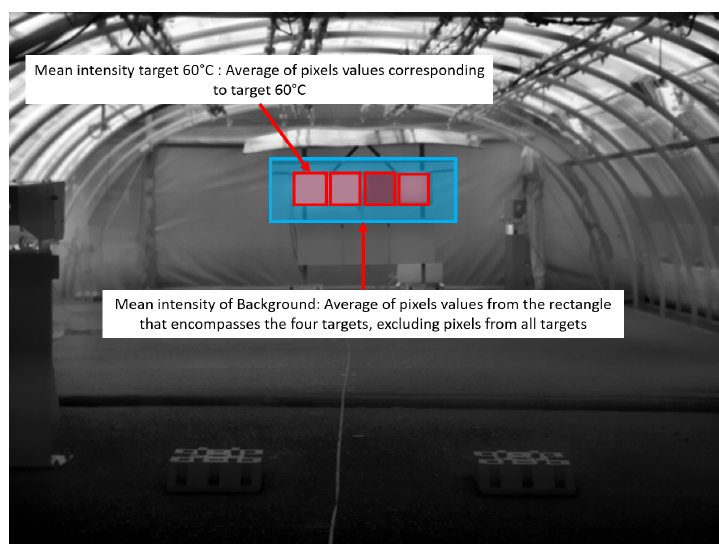
Figure 14. Definition of mean intensity of a target and the